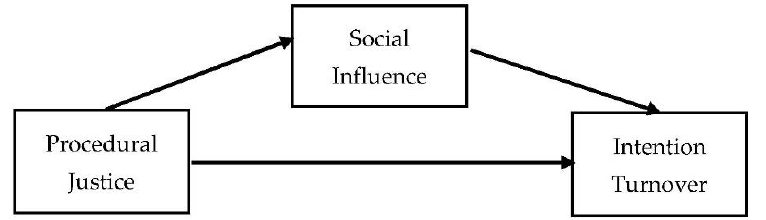
Figure 1. The research conceptual framework.